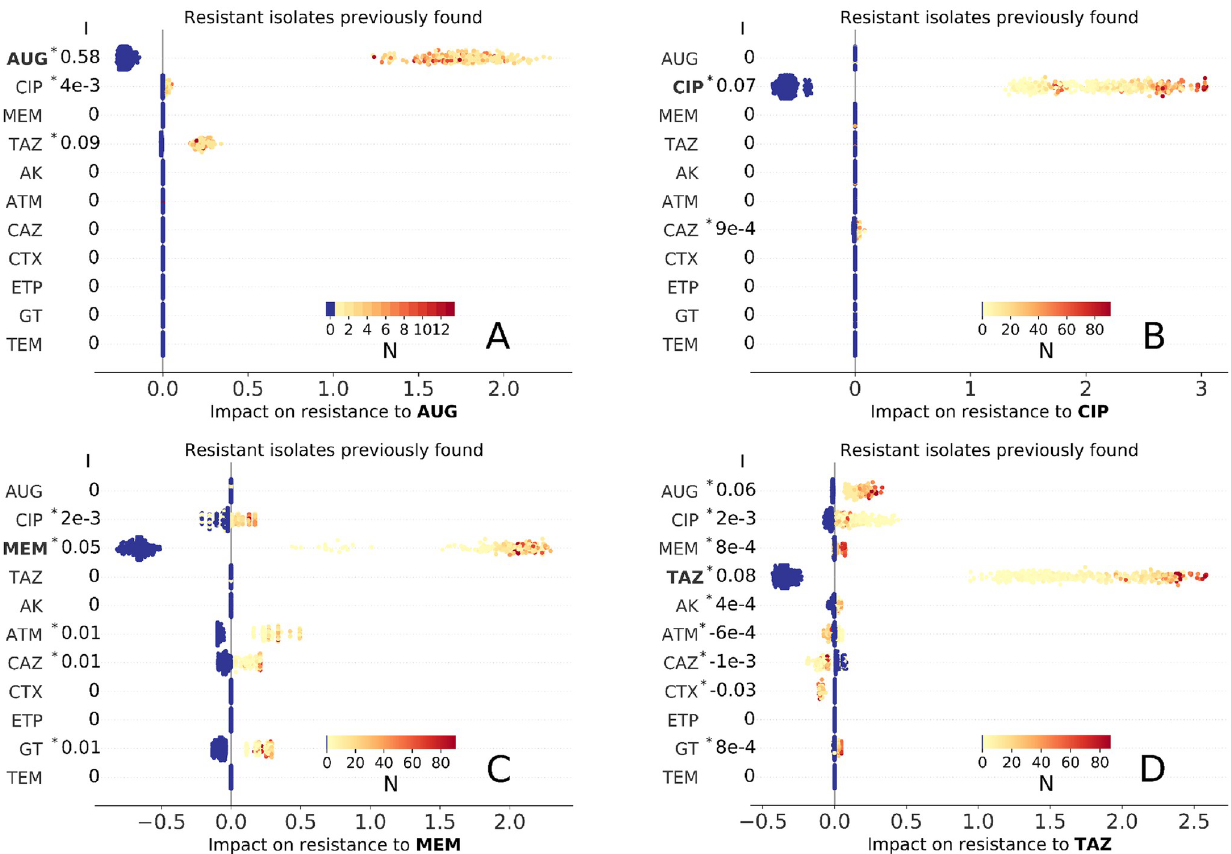
Fig 4. Impact of past resistance reports (obtained by cultures tested during past admission) on resistance to AUG, CIP, MEM, and TAZ treatment (A,B,C, and D panels, respectively). Blue marker color indicates no resistance previously found, while light orange to dark red colors correspond to increasing number N of times an isolate was found resistant in past admissions (inset colormaps). As in Fig 2, each marker represents an admission event and the corresponding Shapley values are represented as horizontal coordinates. Values of the slope index I are reported as measures of the direction and strength of association of the factor with AMR outcome (see also Table E in S1 Text, asterisk ( � ) indicates statistical significance, P <